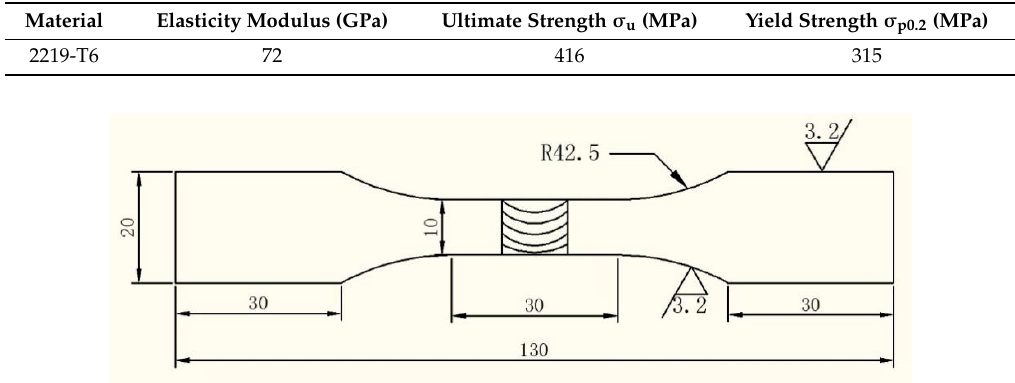
Figure 1. Shape and size of fatigue specimen.